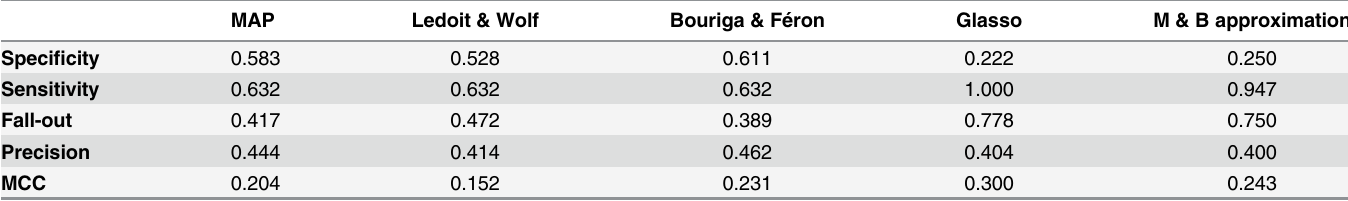
Table 2. Diagnostics for competing